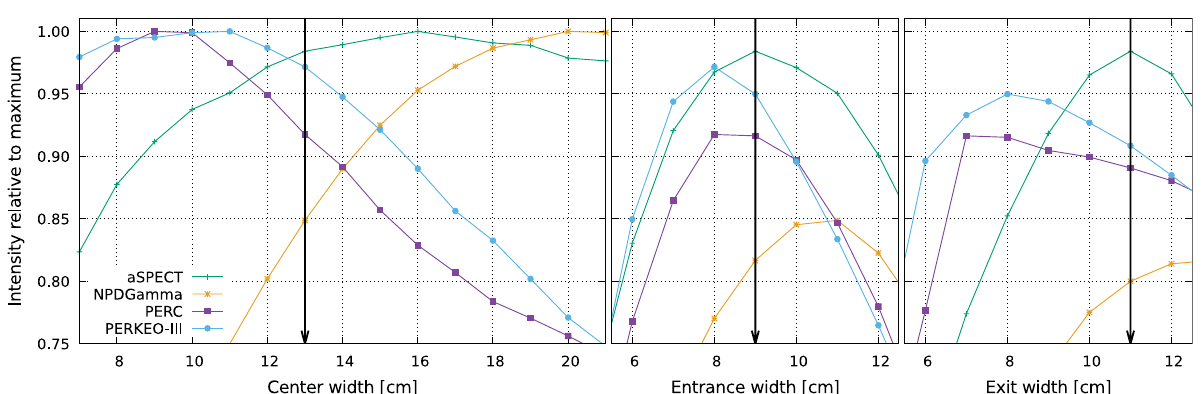
Figure 2. Optimisation of central, exit and entrance width of the guide system. All other guide settings were fixed to the values given in Table 1. Intensities are plotted relative to the maximum for the respective reference experiment (see appendix A) in the full parameter space. In the left plot, the maximum intensities for a given central width and free entrance and exit widths are plotted. The arrow indicates the selected central width (13cm) which is then fixed for the other two plots. In the middle plot, the maximum intensities for a given entrance width and free exit width are plotted; the arrow indicates the selected entrance width (9cm) which is then fixed for the right plot. The right plot shows the intensity as function of the exit width (other widths fixed) and is used to select the exit width of 11cm. Although the positions of the maxima for the different reference experiments are quite different, for the selected compromise the intensities for all reference experiments are above 80% of the respective maximum. This best compromise can be different if one wants to optimise for a certain class of experiments. Note that neither the flux density nor integral flux at the guide exit are good criteria for this optimisation (the flux density can be maximised by minimising the exit width, resulting in a large divergence, and the integral flux by a wider guide, resulting in reduced flux density) and are therefore not plotted.